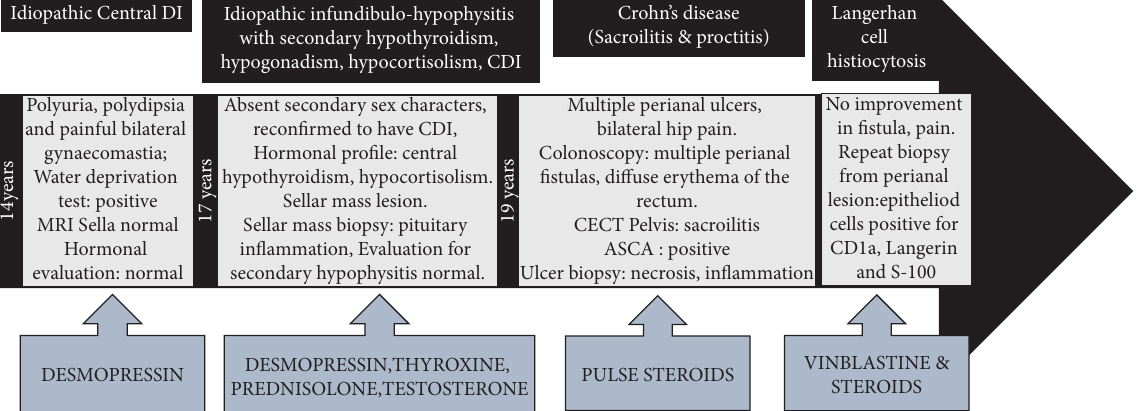
Figure 4: Flow chart showing the clinical course of the